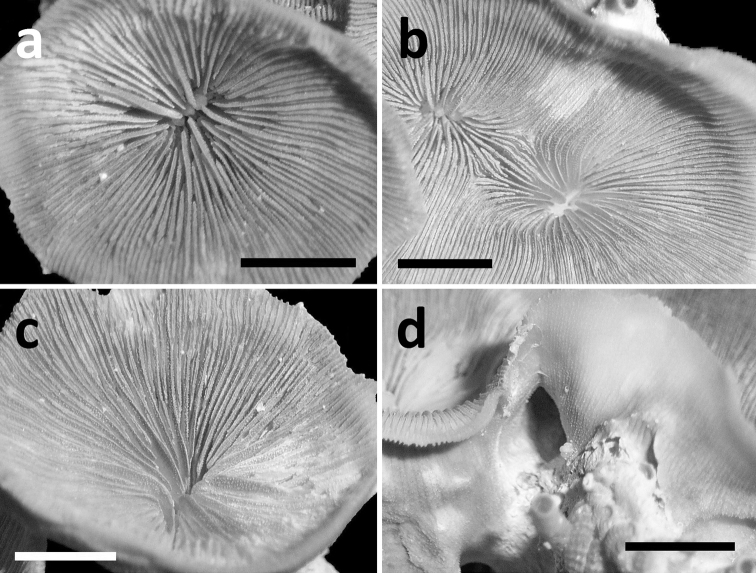
Specimens of Leptoseris troglodyta sp. n. from the Philippines, W of Bohol, NW side of Cabilao Island (RMNH Coel 24195). Scale bars: 5 mm a Single calyx from above, showing nearly solid columella in the fossa b Two totally fused monocentric calices showing, each with its own fossa c Upper side of calyx showing clearly visible granulation on septal sides d Calyx showing solid corallum wall covered by costae with fine granular spines.